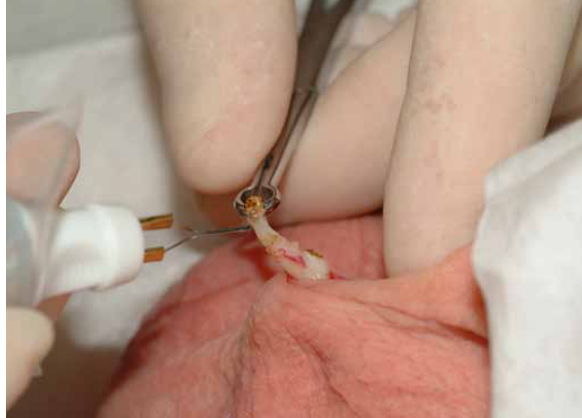
Figure 5 - Cutting the vas with a thermal cautery